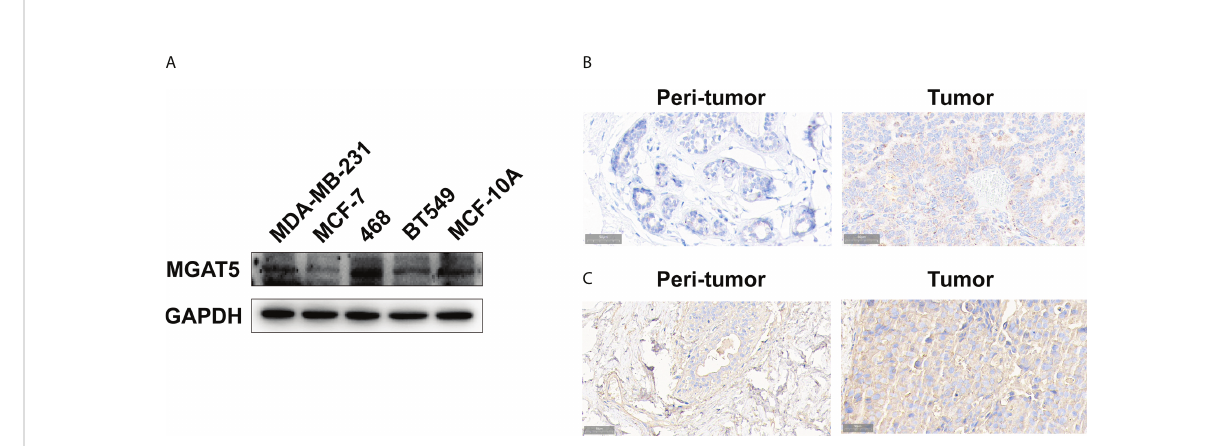
FIGURE 5 The expression of MGAT5 and branching GlcNAc structures in breast cancer. (A) The protein levels of MGAT5 in breast cancer cell lines (western blotting). (B) The MGAT5 level was upregulated in breast cancer (immunohistochemistry). (C) The expression of branching GlcNAc structures was increased in breast cancer samples